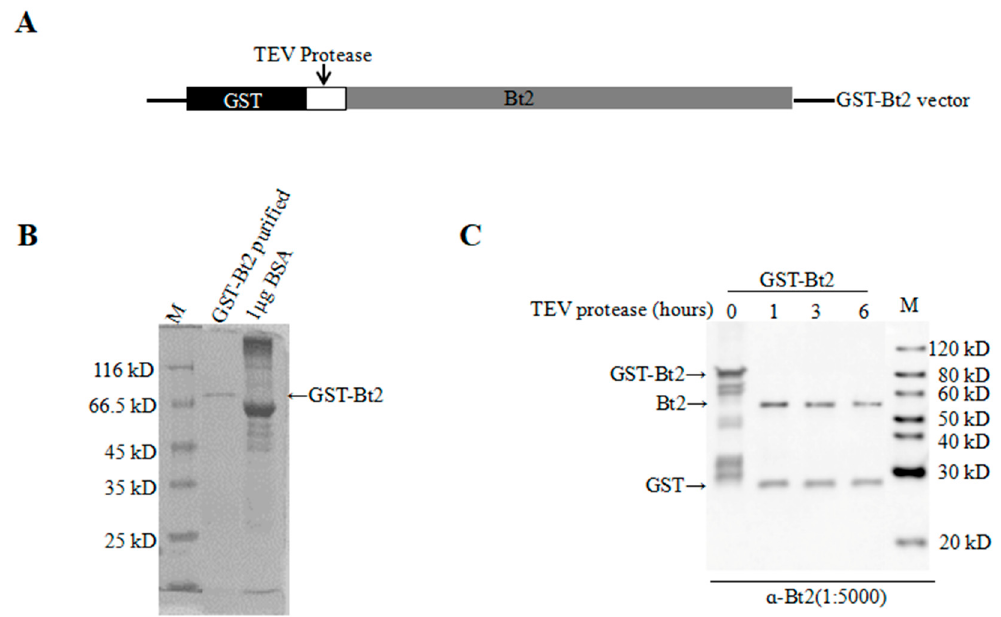
Figure 2. Evaluation of Brittle-2 (Bt2) antibodies using antigen protein purified from GST in vitro. ( A ) Structural diagram of GST-Bt2 vectors. The white region showed the TEV protease site between GST tag and protein interested. ( B ) GST-Bt2 protein purified and BSA standard were detected by coomassie brilliant blue G-250 staining method. The protein marker ladder is indicated in the left column. ( C ) GST-Bt2 digested with TEV protease for 1–6 h by immunoblot. 0.5 µ g protein was loaded in each well. Ratio of antibody dilution was 1:5000.